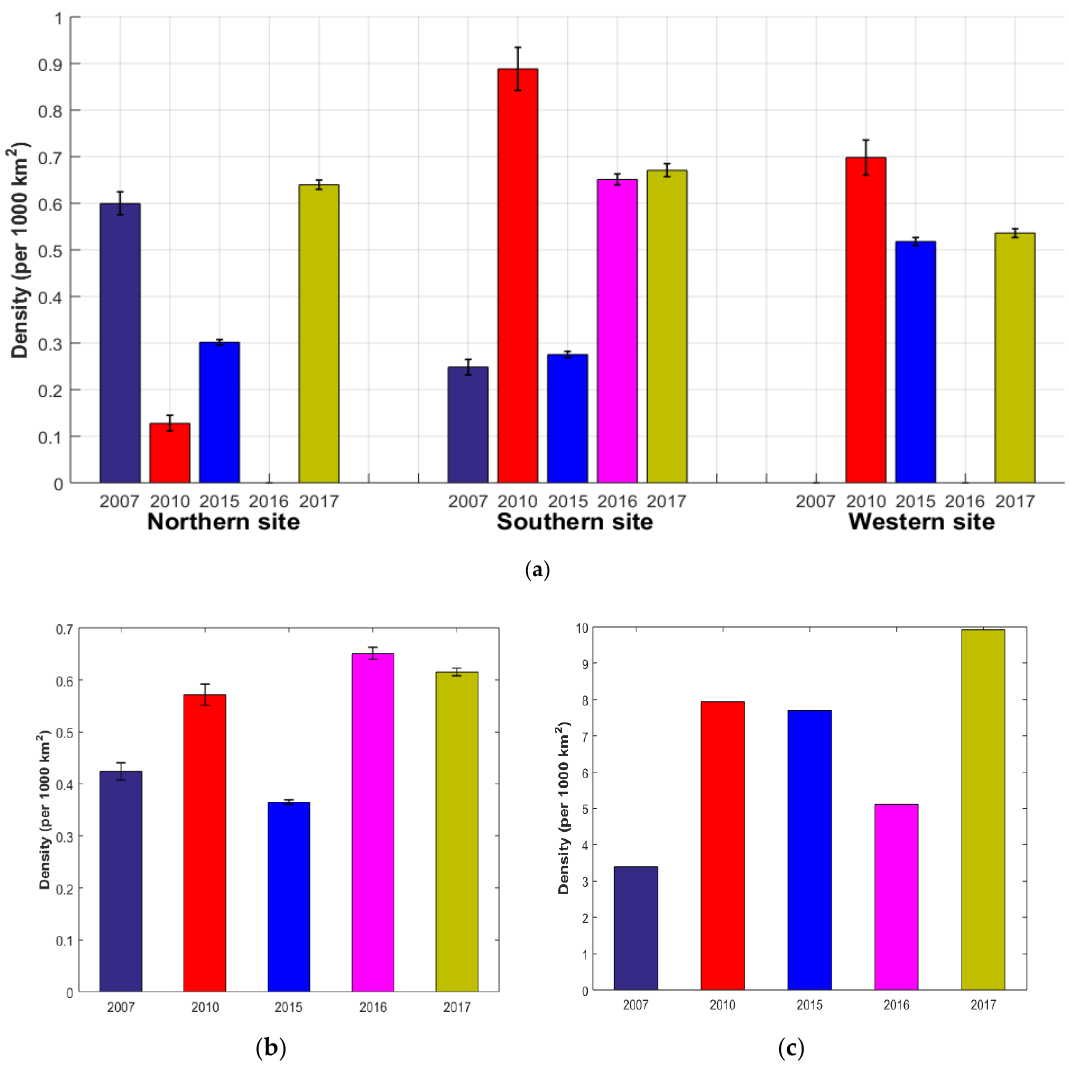
Figure 8. ( a ). Average site-specific density estimates of sperm whales at three sites for different survey years. Colors are different survey years (dark blue: 2007, red: 2010, blue: 2015, magenta: 2016, green: 2017). ( b ) Average abundance density estimates for sperm whales across all sites for each survey year; ( c ) Maximum abundance density estimates for sperm whales at all sites for each survey year. Colors are different survey years (dark blue: 2007, red: 2010, blue: 2015, magenta: 2016, green: 2017).